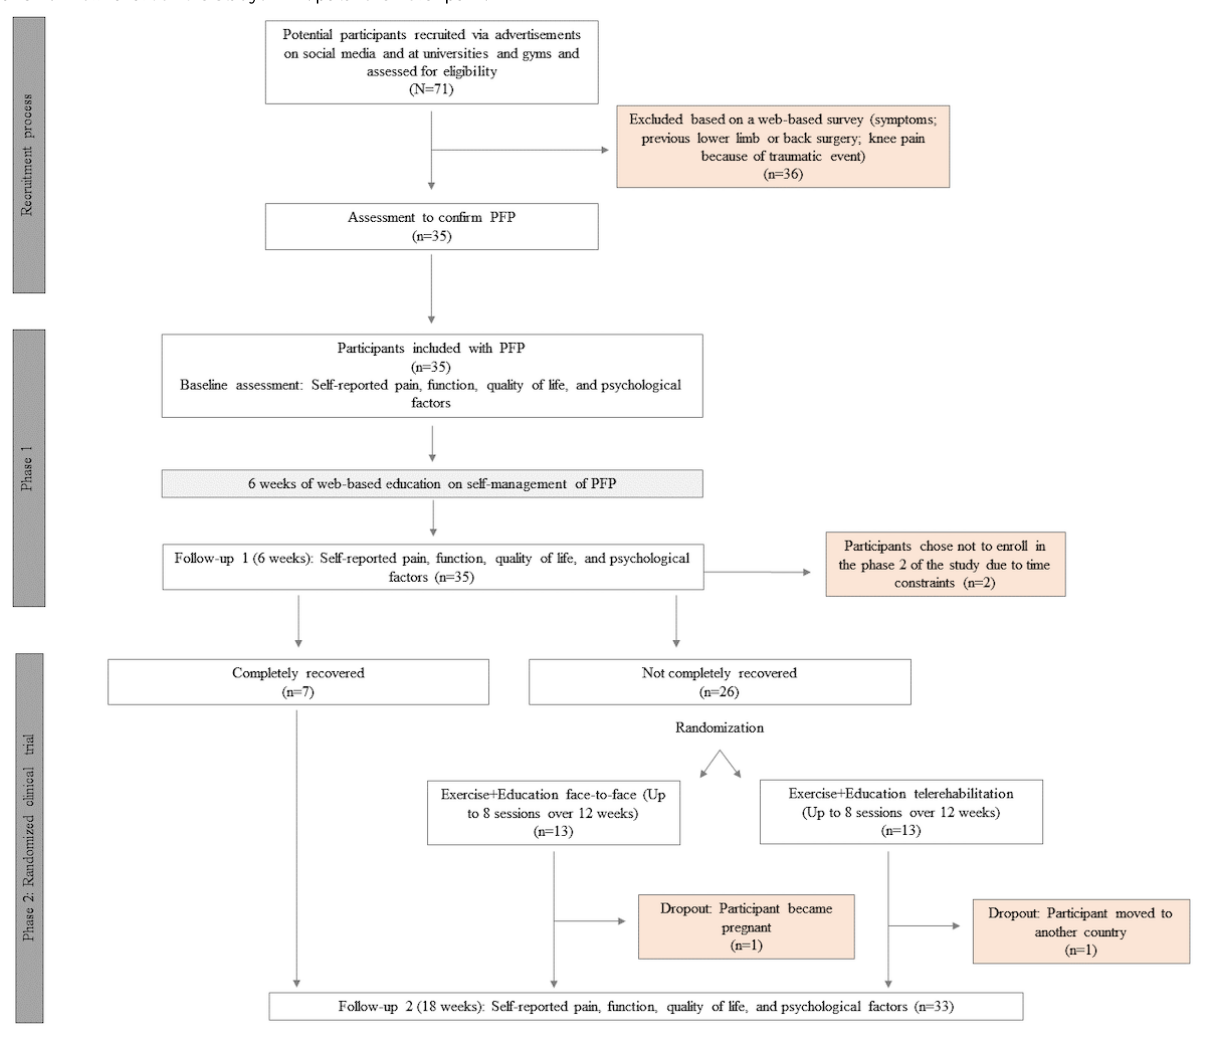
Figure 1. Flow chart of the study. PFP: patellofemoral